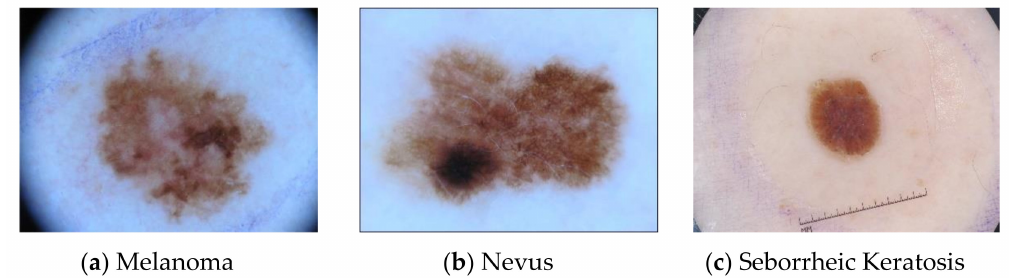
Figure 4. The International Skin Imaging Collaboration (ISIC) 2016 dataset contains two types of skin lesions: malignant (melanoma) ( a ) and benign ( b ). The lesions in these images are matched with the gold standard (definitive) malignant diagnosis, including 900 training images and 379 test dermoscopy images, which have been screened to ensure privacy and quality.